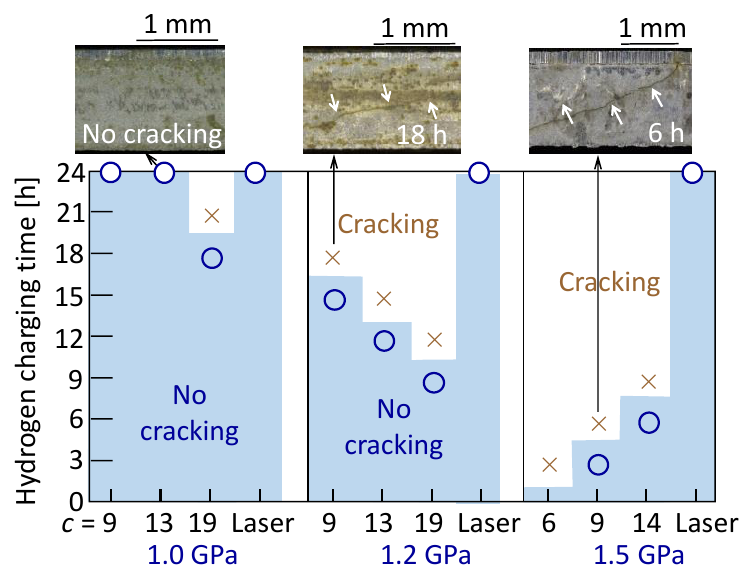
Figure 13. Delayed cracking induced by cathodic hydrogen charging test of cold-blanked and laser-cut ultra-high strength steel sheets [66].